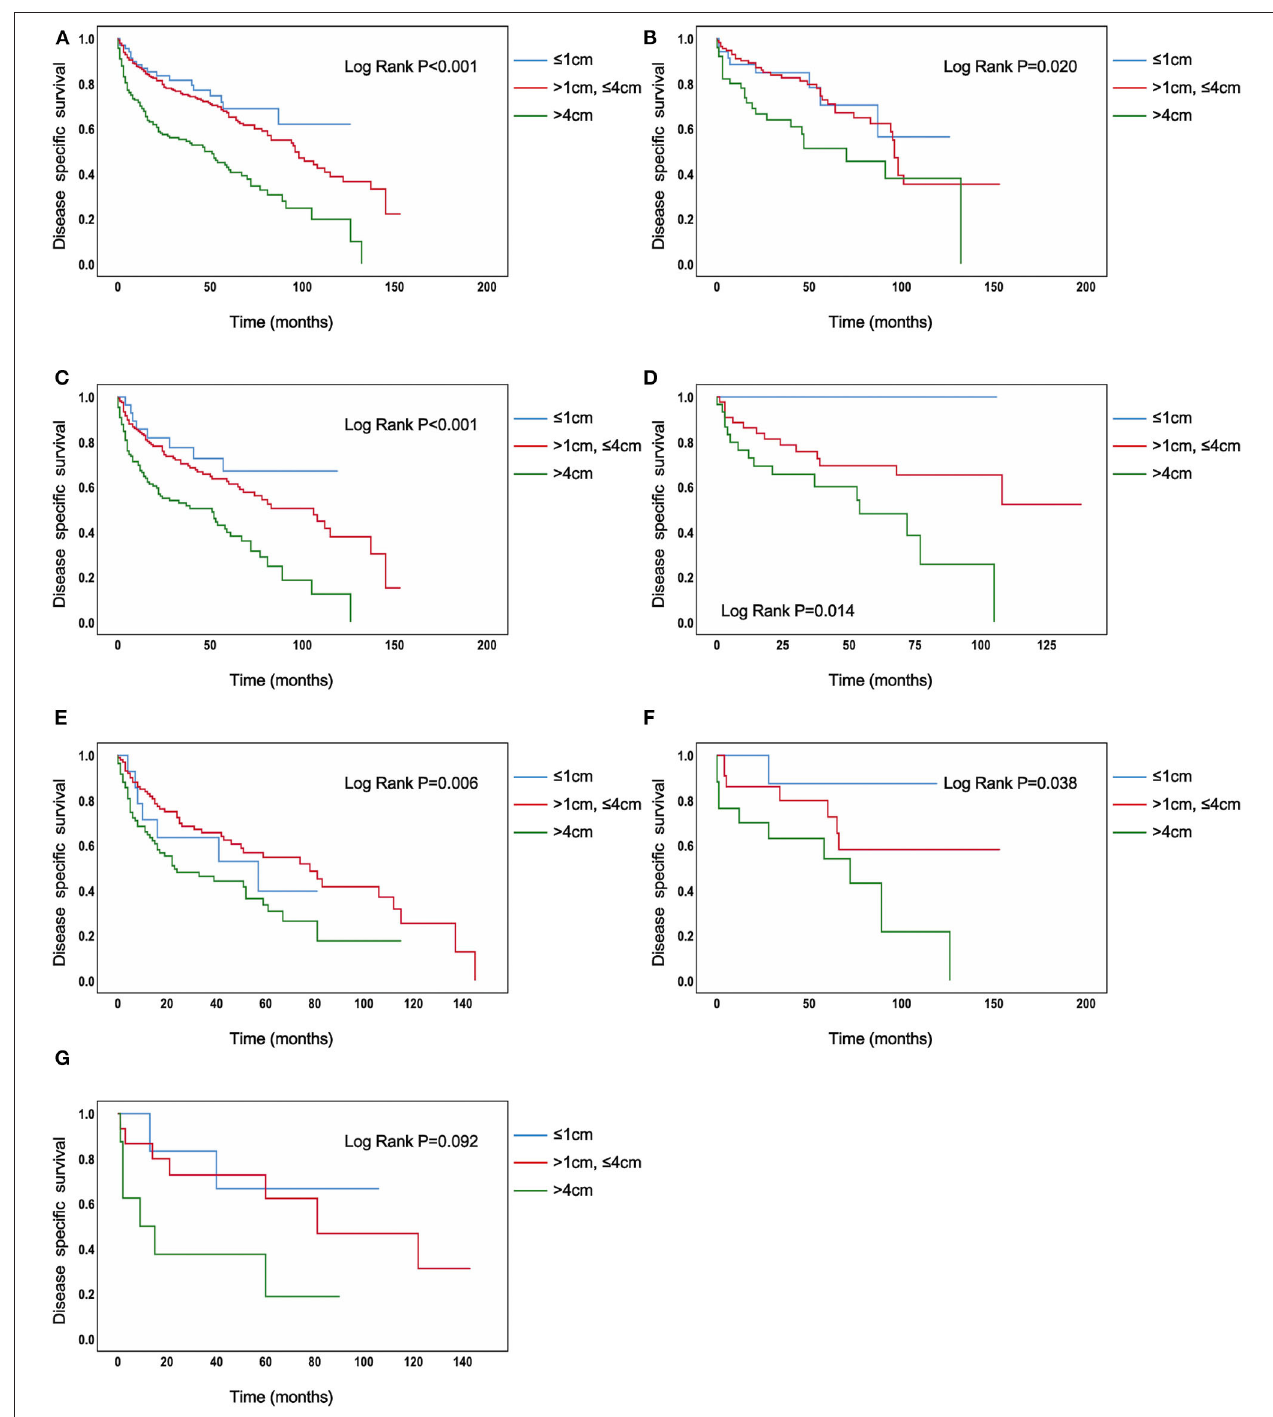
FIGURE 2 | Disease specific survival of papillary thyroid cancer patients with IVB stage stratified by tumor size using Kaplan–Meier analysis and log-rank tests. (A) All papillary thyroid cancer patients. (B) Papillary thyroid cancer patients with N0 category. (C) Papillary thyroid cancer patients with N1 category. (D) Papillary thyroid cancer patients with N1A category. (E) Papillary thyroid cancer patients with N1B category. (F) Papillary thyroid cancer patients with N1NOS category. (G) Papillary thyroid cancer patients with Nx category [ (B–F) Log Rank P < 0.050, (G) Log Rank P = 0.092].